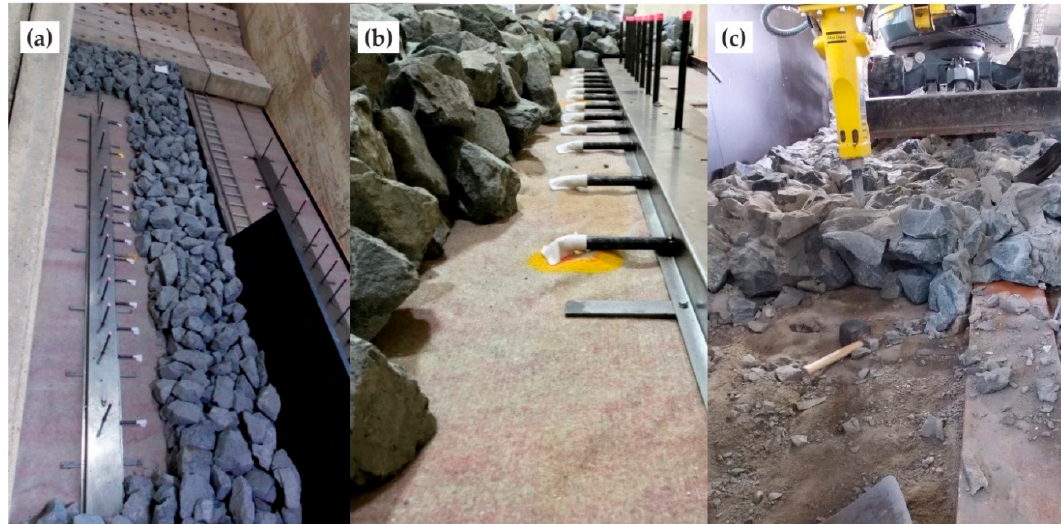
Figure 5. Position of the PTs in the GWK (after [28]).